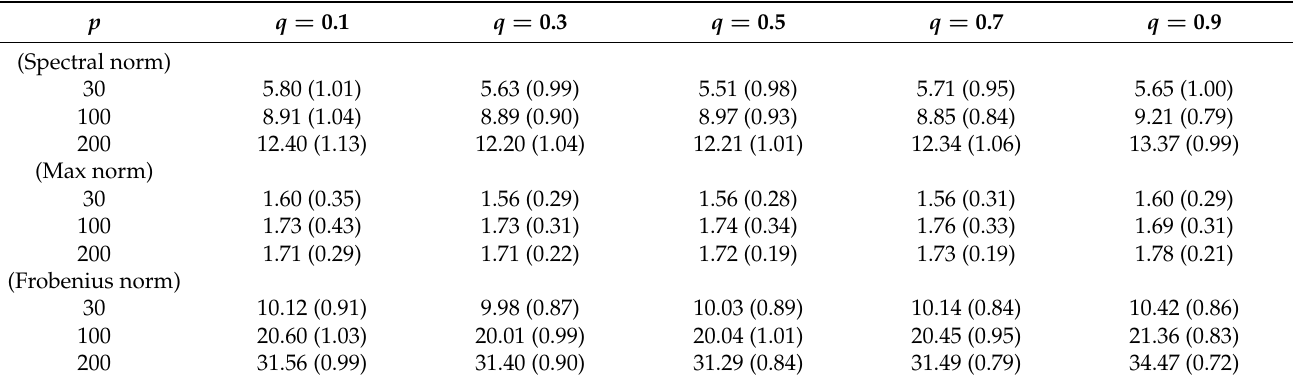
Table 7. Simulation results of the L q -CSCE with different q for Model 3 over 100 replications. The standard errors are given in